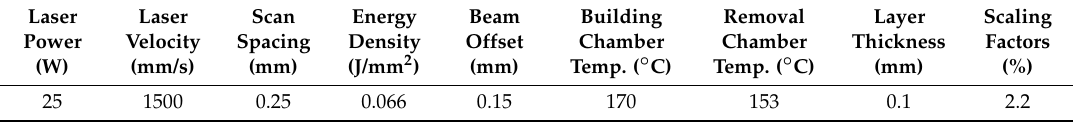
Table 1. Process parameters used in laser sintering of the samples.